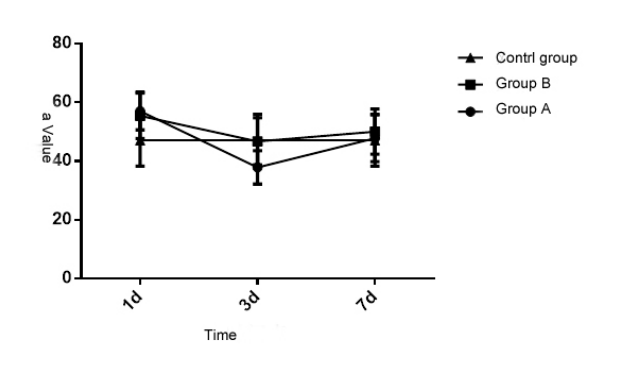
Figure 3: Comparative analysis of α value of the patients in the three groups at different times